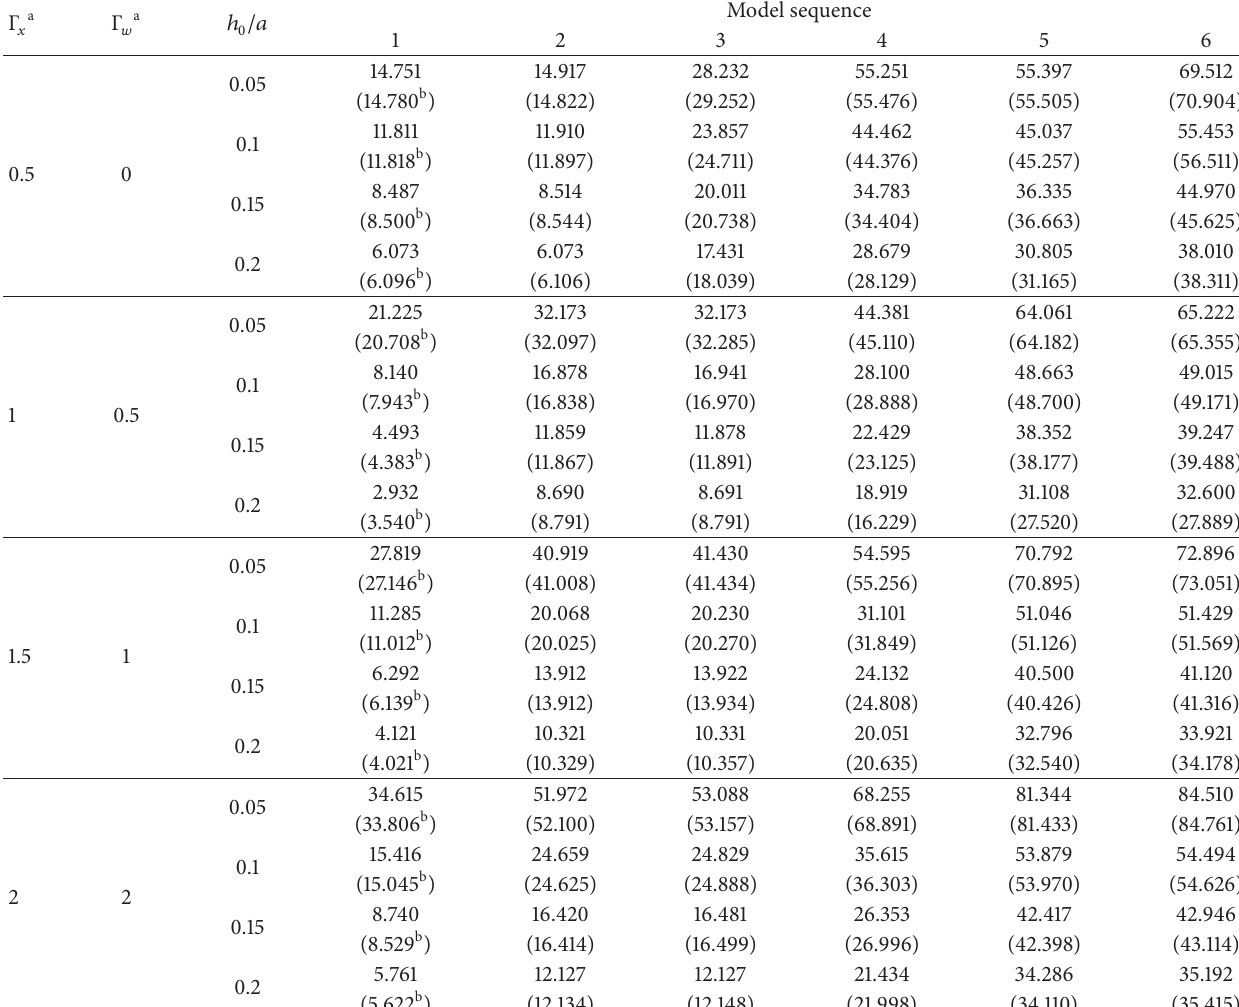
Table 7: Frequency parameter Ω = 𝜔𝑎 2 (𝜌ℎ 0 /𝐷 0 ) 1/2 for moderately thick plates ( 𝑎/𝑏 = 1 ) with linearly varying thickness and elastic rotation and translation support ( ℎ(𝑥,𝑦) = ℎ 0 (1 + 0.5𝑥)(1 + 0.5𝑦) , 𝐾 𝑥0 = 𝐾 𝑥𝑎 = 𝐾 𝑦0 = 𝐾 𝑦𝑏 = Γ 𝑥 , and 𝑘 𝑥0 = 𝑘 𝑥𝑎 = 𝑘 𝑦0 = 𝑘 𝑦𝑏 = Γ 𝑤